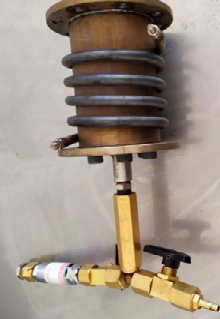
Figure 8. Reactor. Figure 8. Reactor.